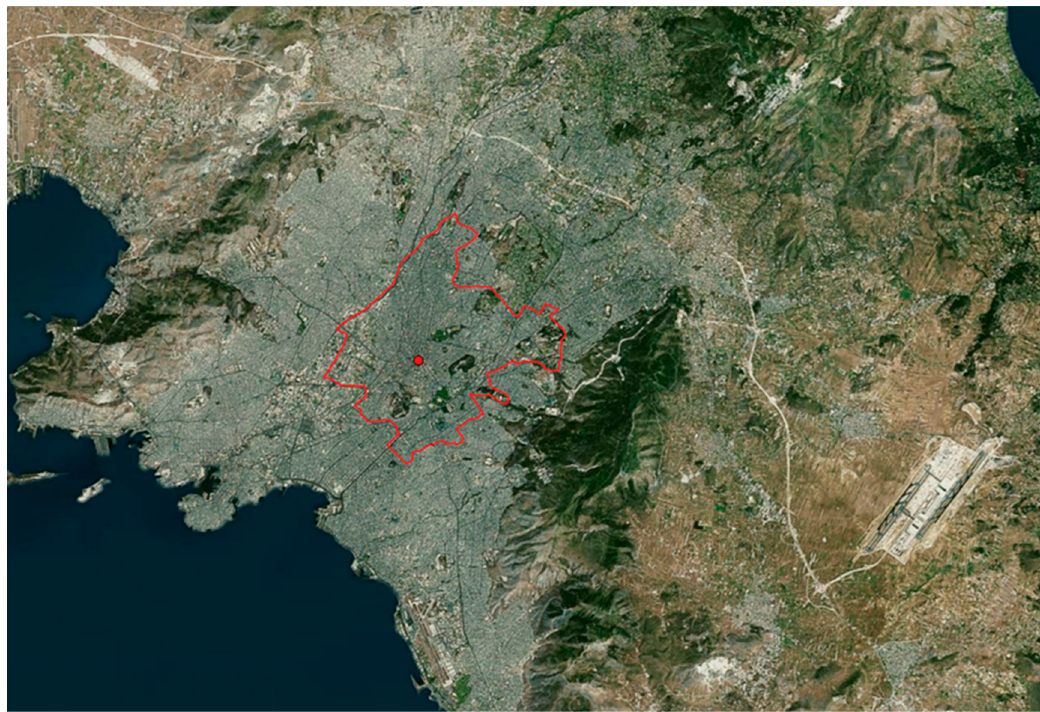
Figure 3. The urban agglomeration of Athens and the administrative boundaries of the municipality of Athens (red polygon).